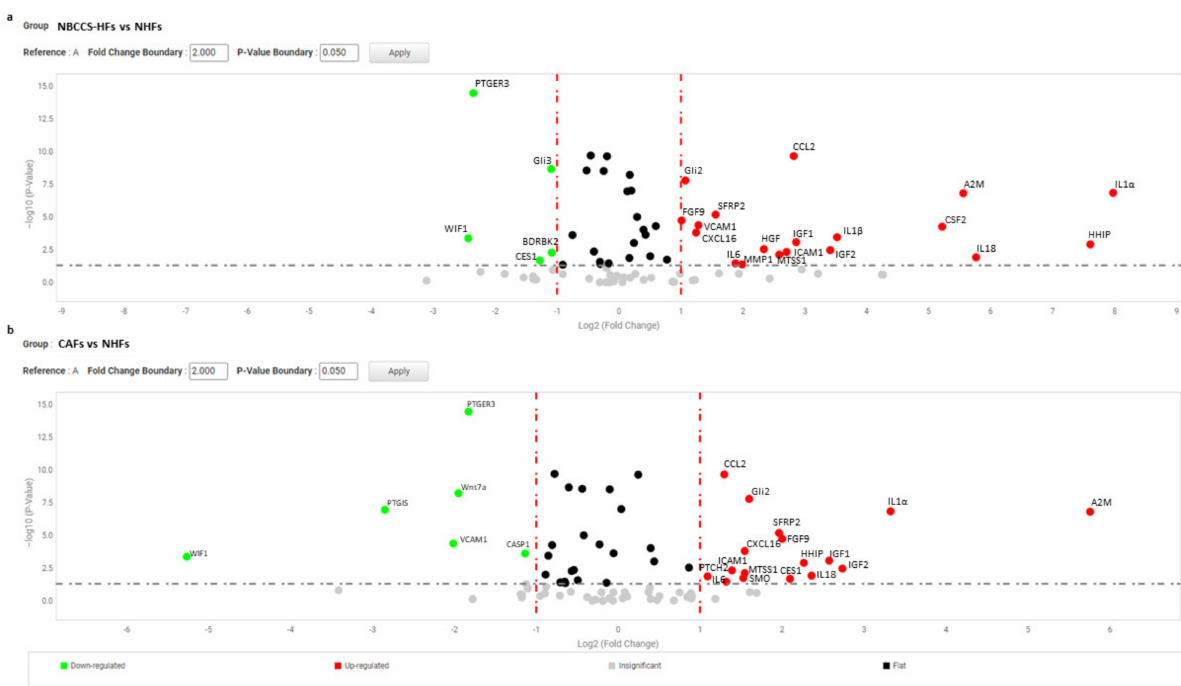
Figure 2. ( a ) Volcano plot represents basal gene expression analysis comparing NBCCS-HFs (n = 9) mRNA to NHFs (n = 9) mRNA level of expression. ( b ) Volcano plot represents basal gene expression analysis comparing CAFs (n = 6) mRNA to NHFs (n = 9) mRNA level of expression. Analysis was performed combining three different housekeeping genes ( β -actin, GAPDH and 18 s). One-way ANOVA statistical test with thresholds >2.0 fold-change and p < 0.05 defined significant increase are reported in red; significant decrease <0.5 fold-change and p < 0.05 reported in green; any fold-difference with p ≥ 0.5, e.g., insignificant are reported in grey; ≤ 2.0 or ≥ 0.5 difference e.g., flat reported in